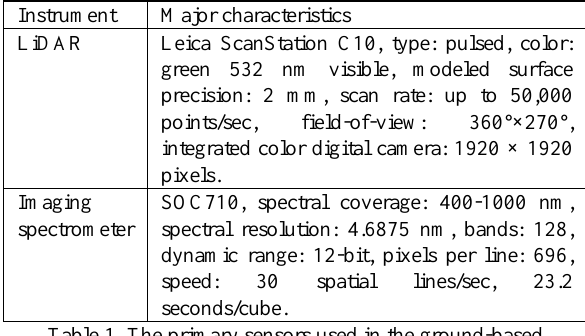
Table 1. The primary sensors used in the ground-based